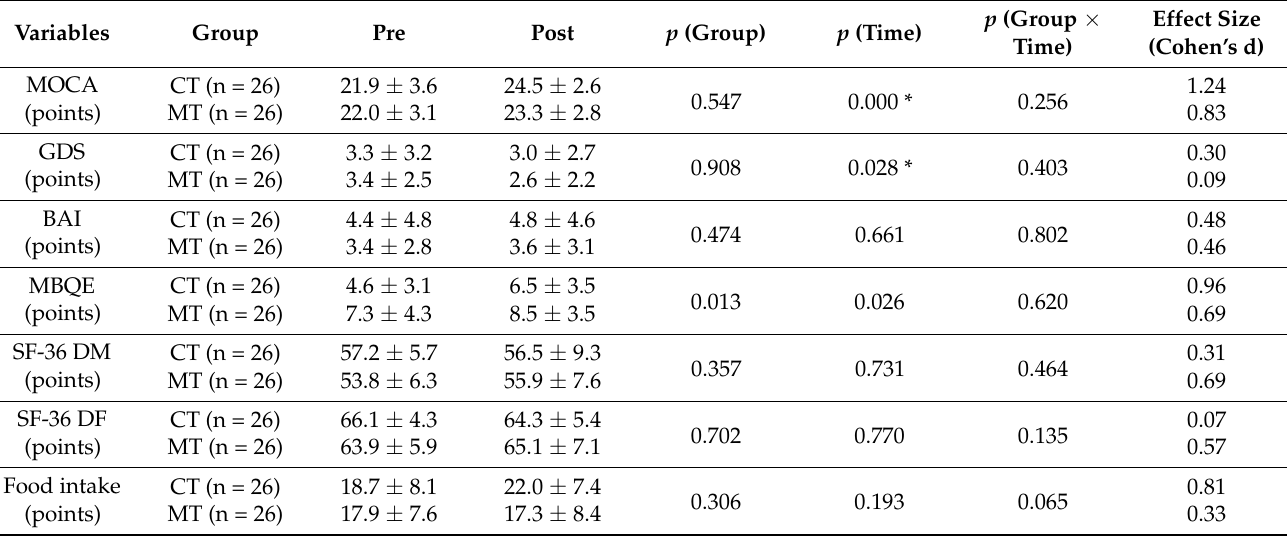
Table 3. Mean ± standard deviation of global health assessment pre- and